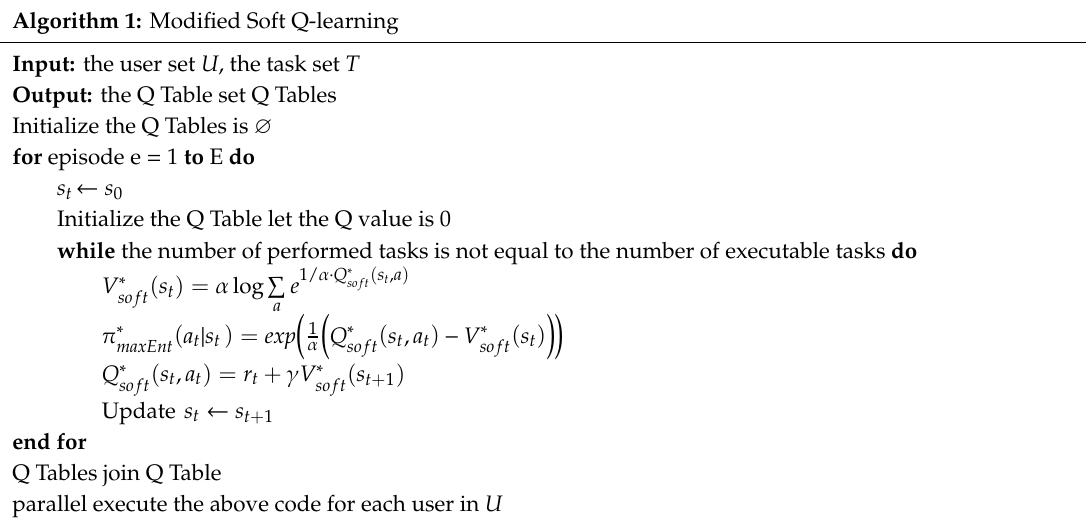
Algorithm 1: Modified Soft